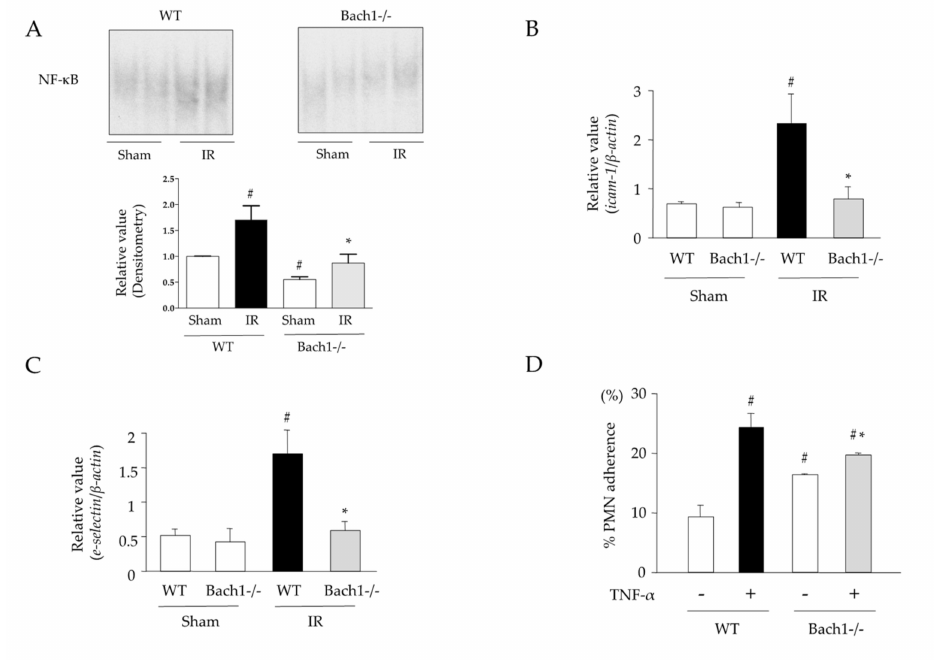
Figure 3. Effects of Bach1 deficiency on NF- κ B activation, expression levels of adhesion molecules, and neutrophil-endothelial cell interaction in intestinal IR injury. ( A ) A representative electrophoretic mobility shift assay (EMSA) image and densitometry analysis ( n = 4–6). ( B ) Intercellular adhesion